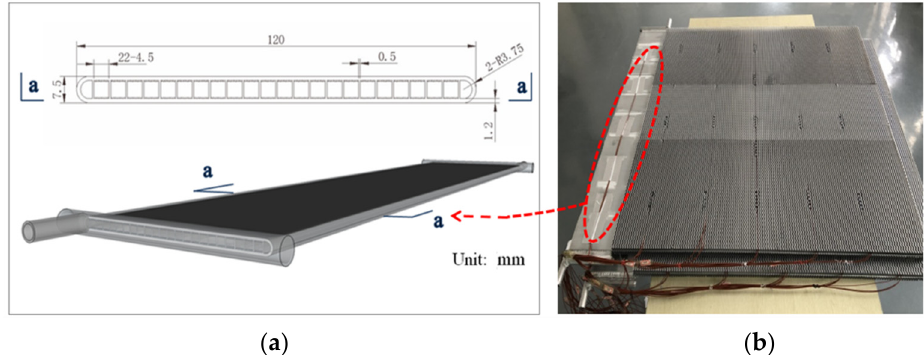
Figure 3. Heat transfer unit of MHPA–AWHE: ( a ) structure of PFT; ( b ) photo of heat transfer com- ponents.